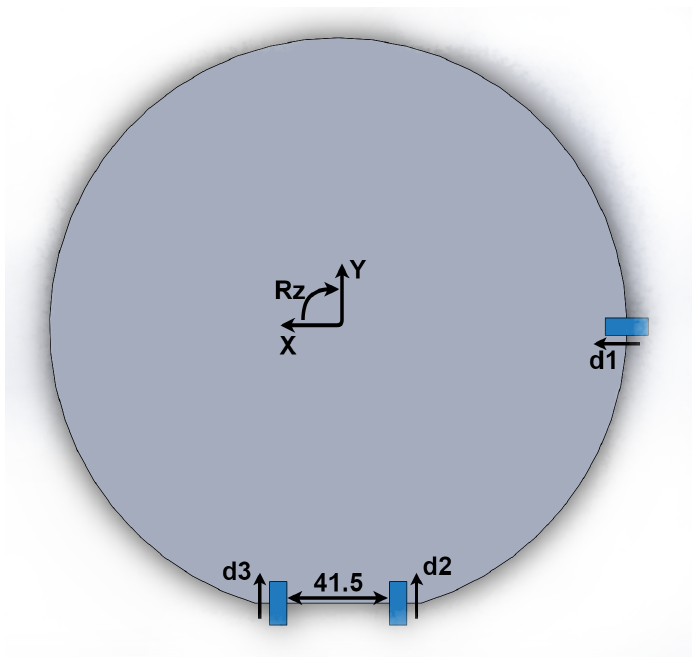
Figure 21. The sensor placement in reference to the wafer to be